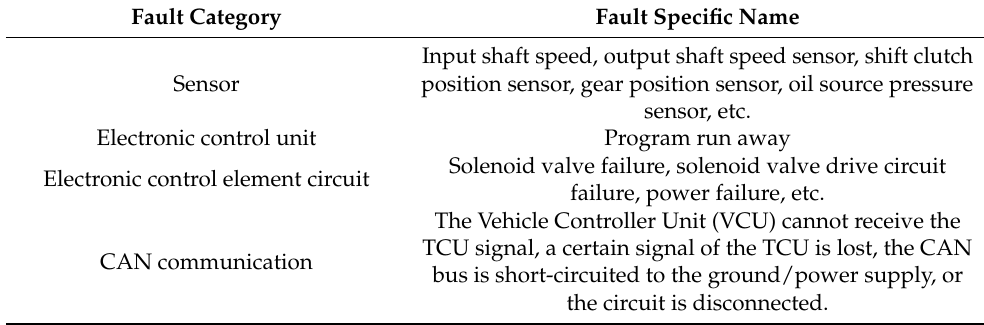
Table 1. TCU electronic control system